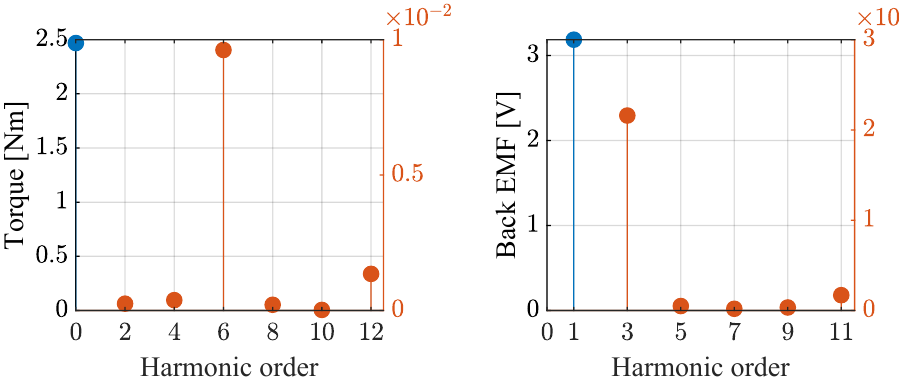
Figure 5. Electromagnetic torque and back emf harmonic orders obtained by applying FFT on waveforms for JT = 4.39935 mm, TWS = 6.9565 mm, SO = 1.8815 mm, SOAng = 116.65 deg., TGD = 0.98125